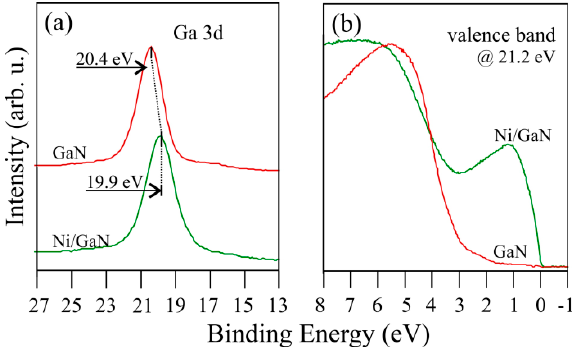
Figure 19. Normalized spectra of ( a ) Ga-3d peaks and ( b ) valence band for bare and Ni-film-covered GaN(0001) surfaces. Mean Ni film thickness is 3 nm.